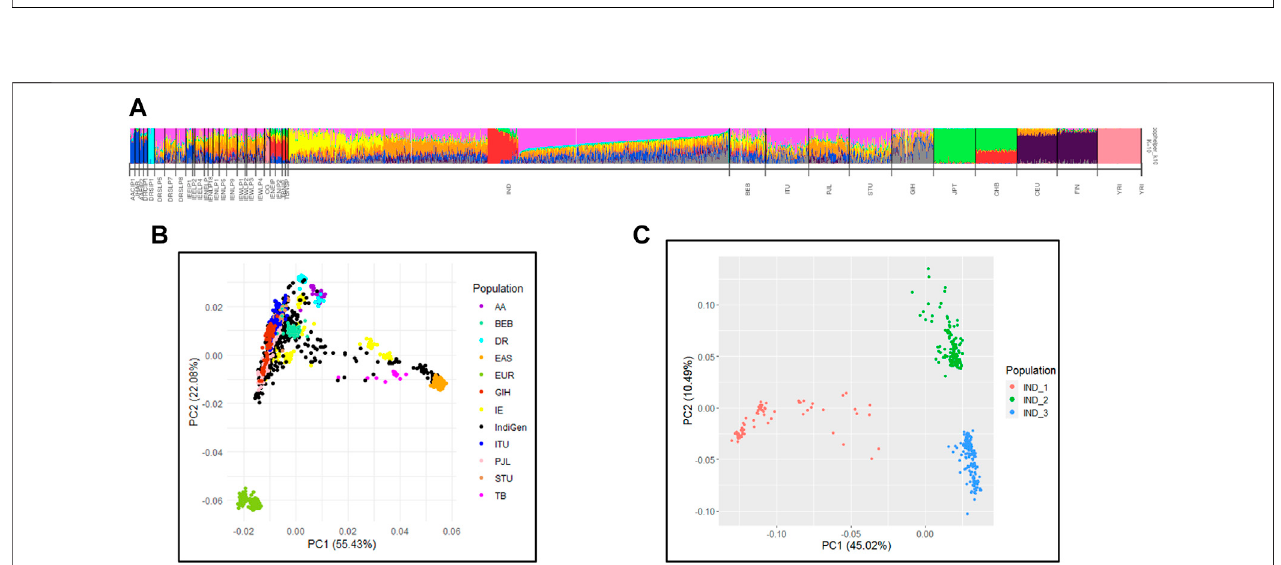
FIGURE 2 | Population genetic structure interpretation of IndiGen with IGV and 1000G datasets by (A) ADMIXTURE analysis and (B) PCA (C) PCA plot showing three IndiGen groups of pure ancestral components.